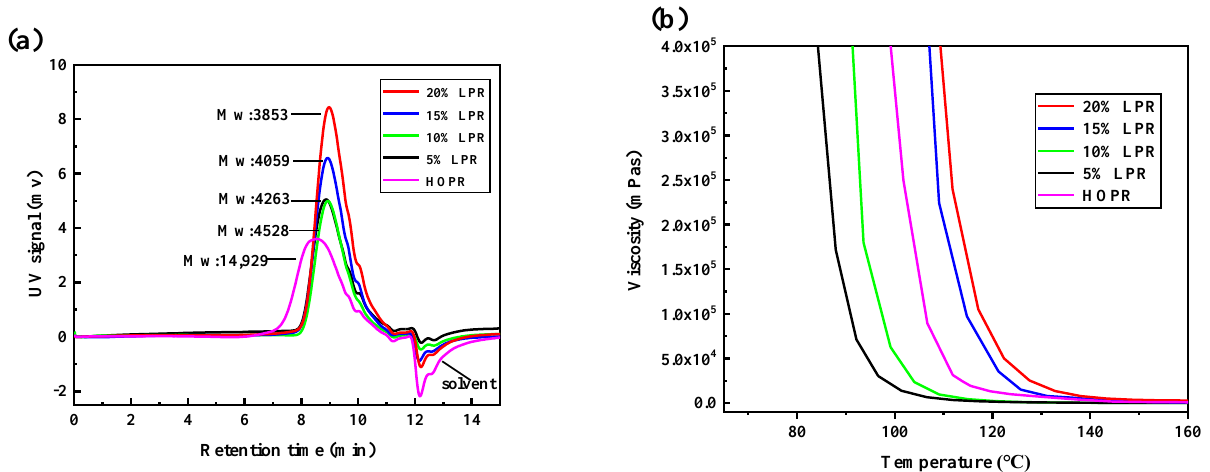
Figure 3. ( a ) GPC chromatograms of LPRs and HOPR; ( b ) the viscosity-temperature curves of LPRs and HOPR. Table 1. O/P value, PDI and molecular weight of LPRs and HOPR.